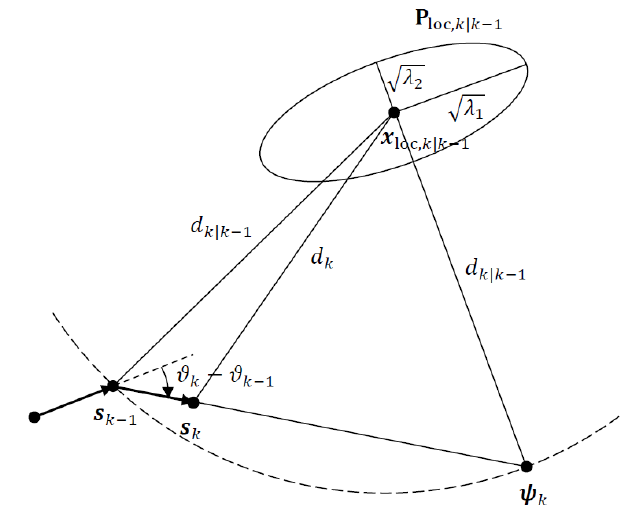
Figure 5. Closed-form projection algorithm to determine the next waypoint s k . The heading angle ϑ k is constrained by the turn-rate | ϑ k − ϑ k − 1 | < ϑ max